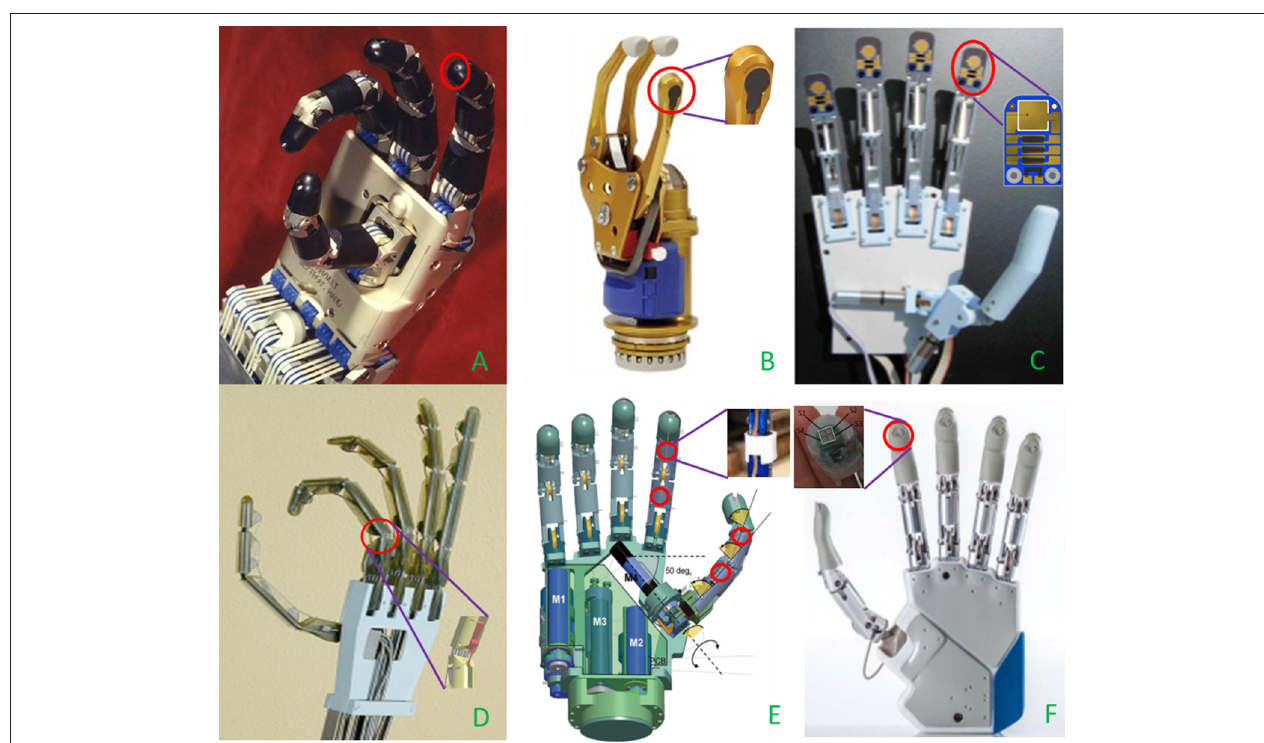
FIGURE 2 | Details of the tactile sensors (red circles) embedded in prosthetic hands. (A) Piezo-resistive sensor on fingertips of UTAH-MIT Hand 8 (Courtesy of Compuer Histiry Museum) (B ) Stain gauges based SUVA system integrated in the thumb of SensorHand Speed 9 (C ) Tactile sensor with piezo-electric, piezo-resistive and thermal sensing units mounted on Southampton Hand (Cotton et al., 2007); (D) Strain gauge placed on PIP joint of UB Hand III (Lotti et al., 2004); (E) Optical sensors on thumb and index of SmartHand (Cipriani et al., 2011); (F) MEMS tactile sensors on fingertips of IH2 Azzurra 10 (Courtesy of Prensilia